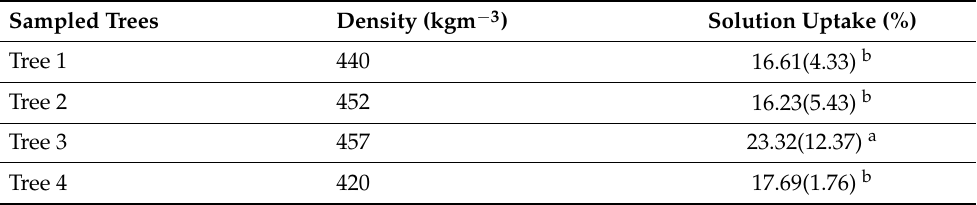
Table 3. Mean values (standard deviations) for solution uptake among the sampled trees of Gmelina arborea . Sampled Trees Tree 1